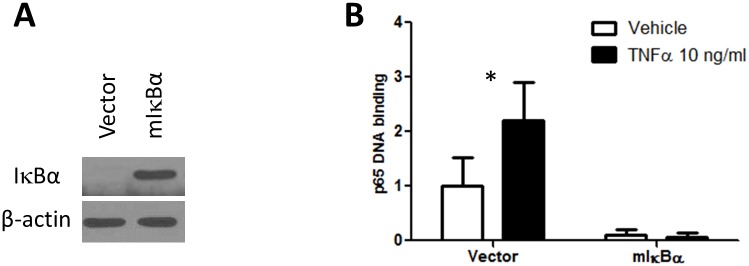
mIκBα transduction of BCPAP cells causes IκBα accumulation (A) and inhibition of both baseline and TNFα-stimulated p65 DNA binding (B).Data are normalized to the vehicle treated vector group. *—p<0.01 for the effect of TNFα in the vector group (two-way ANOVA followed by Bonferroni posttest).